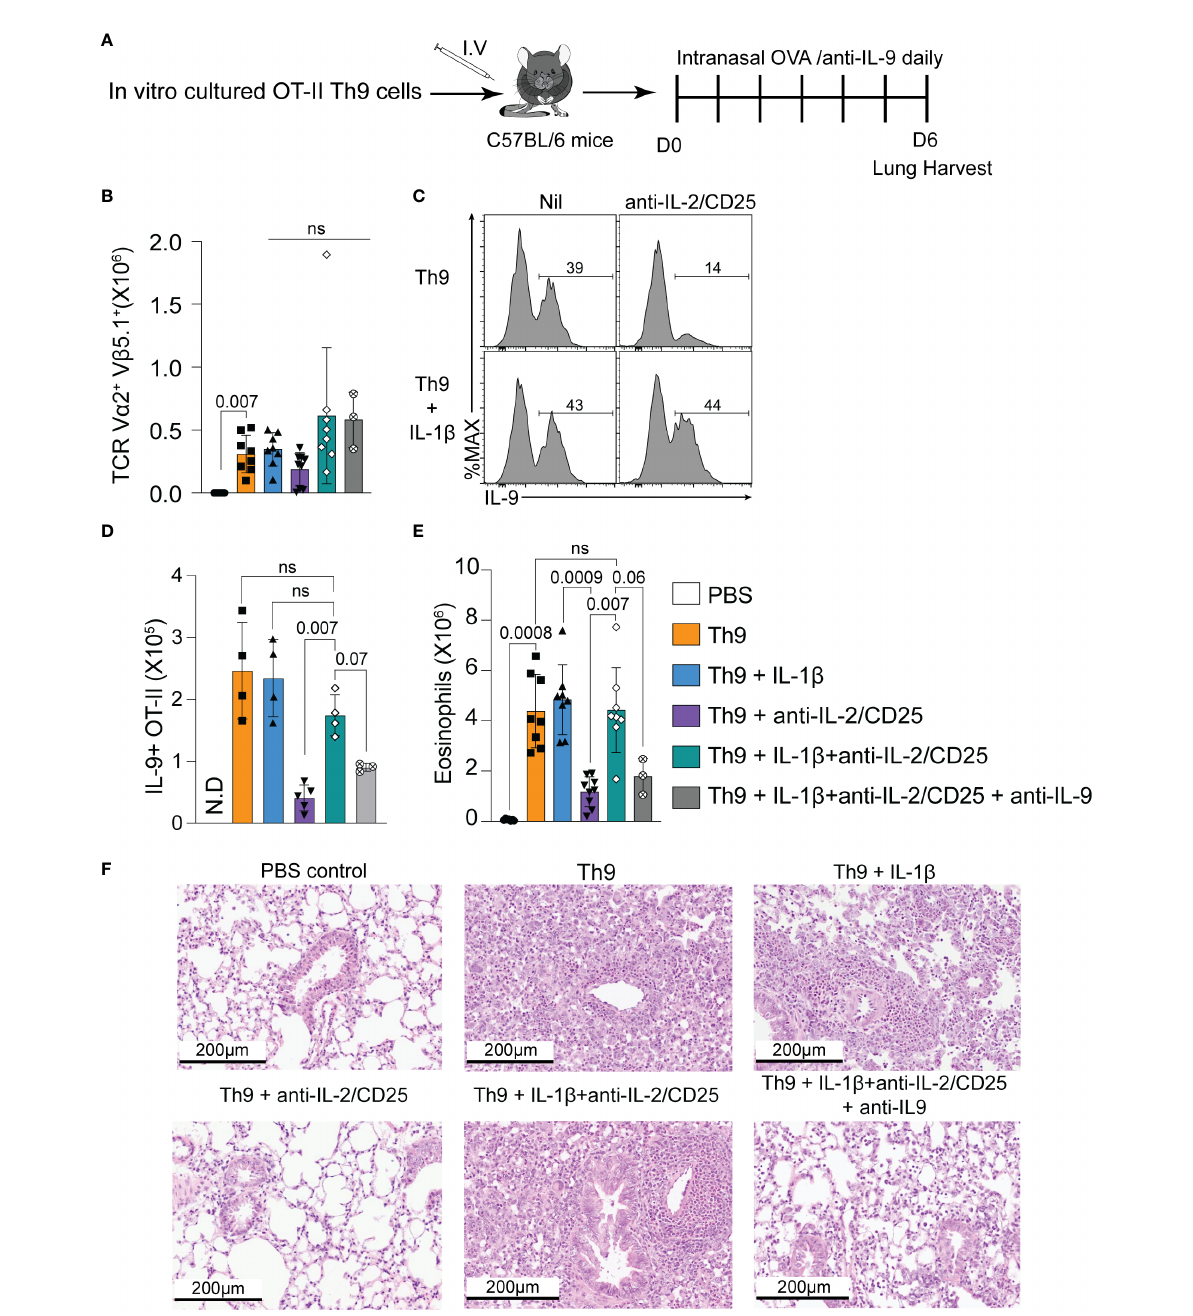
FIGURE 3 IL-1 b rescues the in vivo IL-9-dependent in fl ammatory capacity of IL-2-deprived Th9 cells. (A) Schematic of the experimental design of the Ovalbumin (OVA)-induced allergy model after adoptive transfer of indicated Th9 cells. (B) Total number of V a 2/V b 5 + OT-II CD4 T cells in the lung 24 hours post- fi nal intranasal OVA exposure. (C) Representative histograms of IL-9 staining from V a 2/V b 5 + OT-II CD4 T cells isolated from lungs, gating indicates percentage of OT-II cells expressing IL-9. (D) Total cell number of IL-9- producing V a 2/V b 5 + OT-II CD4 T cells in each group. Each data point represents one mouse. n= 4 for Th9, Th9+ Il-1 b , and Th9+ IL-1 b anti-IL-2/CD25. n=5 for Th9+ anti-IL-2/CD25, and n=3 for Th9+ IL-1 b anti-IL-2/CD25 + anti-IL-9. N.D: non determined (E) Total pulmonary eosinophil numbers in indicated recipient mice. Data are representative of 3-7 mice per group from 2-3 pooled experiments for every group except the anti-IL-9 treated mice. This group was only included in one experiment where there were three mice. (F) Representative H&E images of recipient mice lung tissue harvested on day 6 after OVA treatment and adoptive OT-II cell transfer. Data are considered signi fi cant if p value ≤ 0.05 in a one-way ANOVA analysis with a Tukey post-test. Error Bars indicate standard deviation. ns, non-signi fi